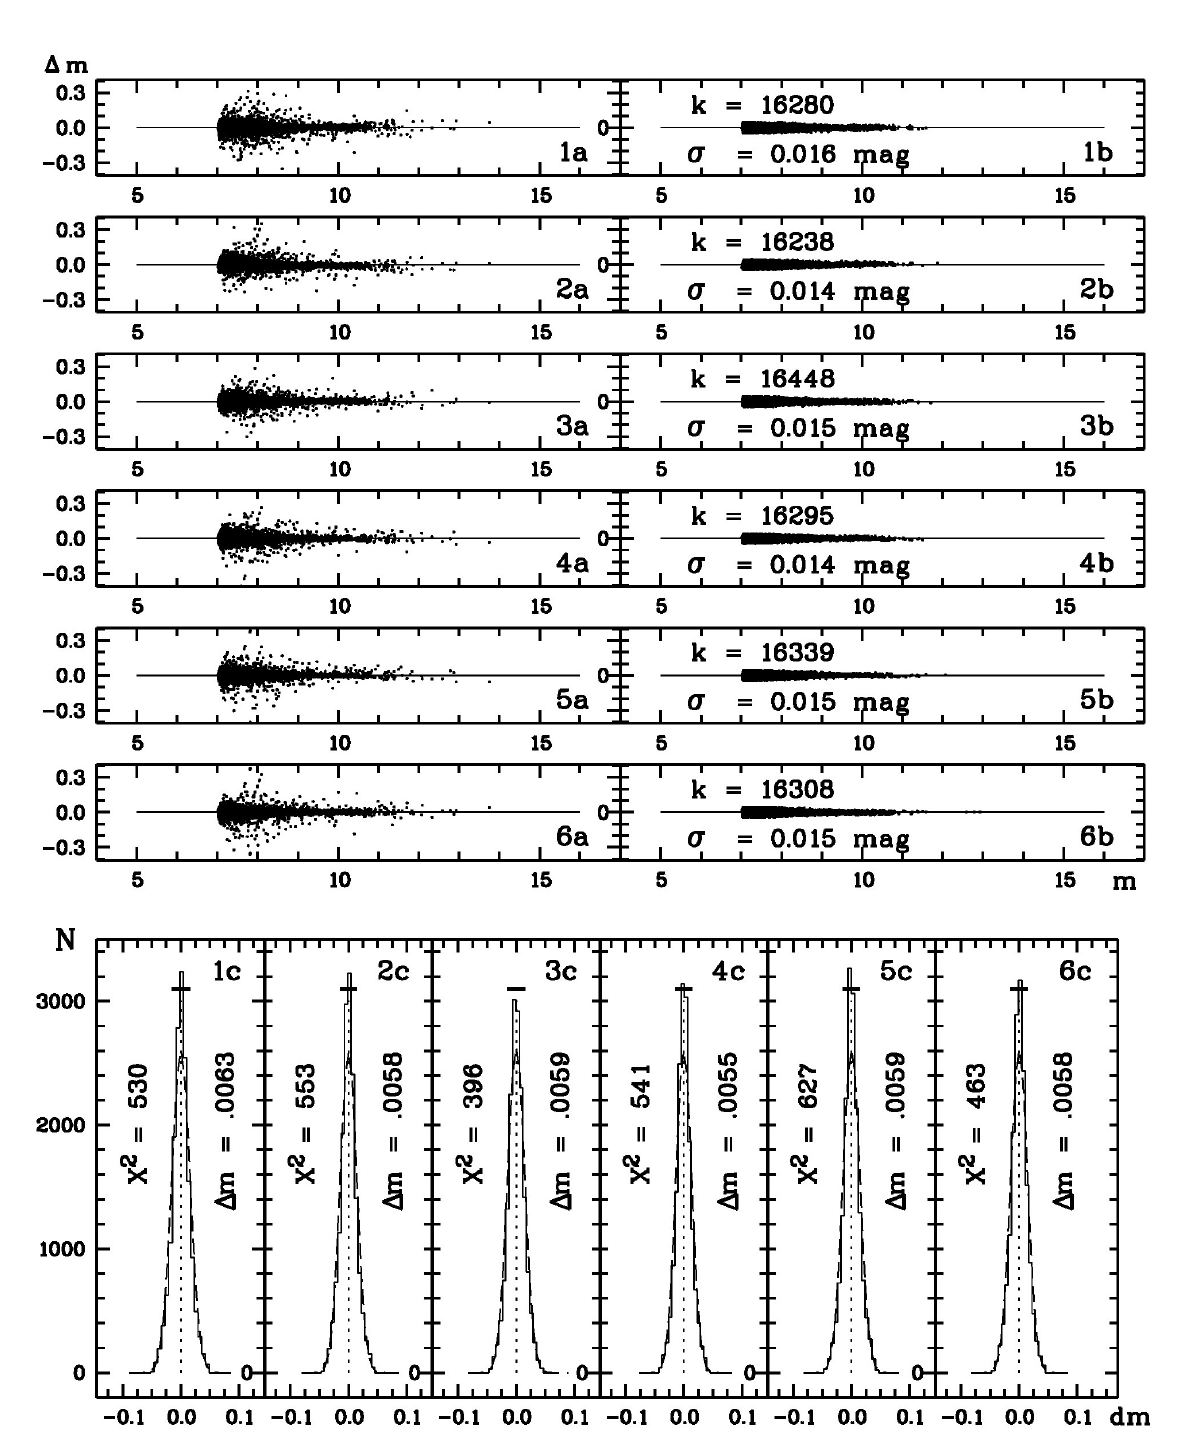
Figure 5c. The differences for the six consecutive scans relatively to the average scan for the instrumental value m. On the bottom the fre- quency distribution of the differences. The values are given in the form of real(solid lines) and theoretical(dash lines) distribution functions for the respective intervals. The value of interval length ∆m and the value X 2 (on the right and the left respectively) are